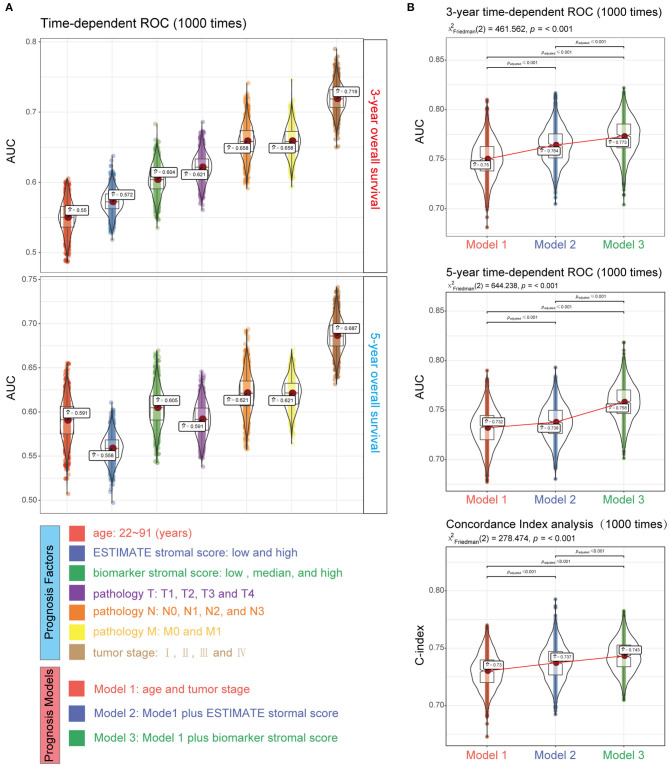
Performance of the biomarker stromal score in prognosis prediction compared with clinicopathological features. (A) Boxplots show the prediction accuracy for 3- and 5-year overall survival, based on the AUC with 1,000× bootstrap resampling for each parameter. (B) The top and middle boxplots show the prediction accuracy for 3- and 5- year overall survival based on the AUC with 1,000× bootstrap resampling, while the bottom boxplot shows the prediction accuracy for overall survival based on the C-index with 1,000× bootstrap resampling for each prognosis model.